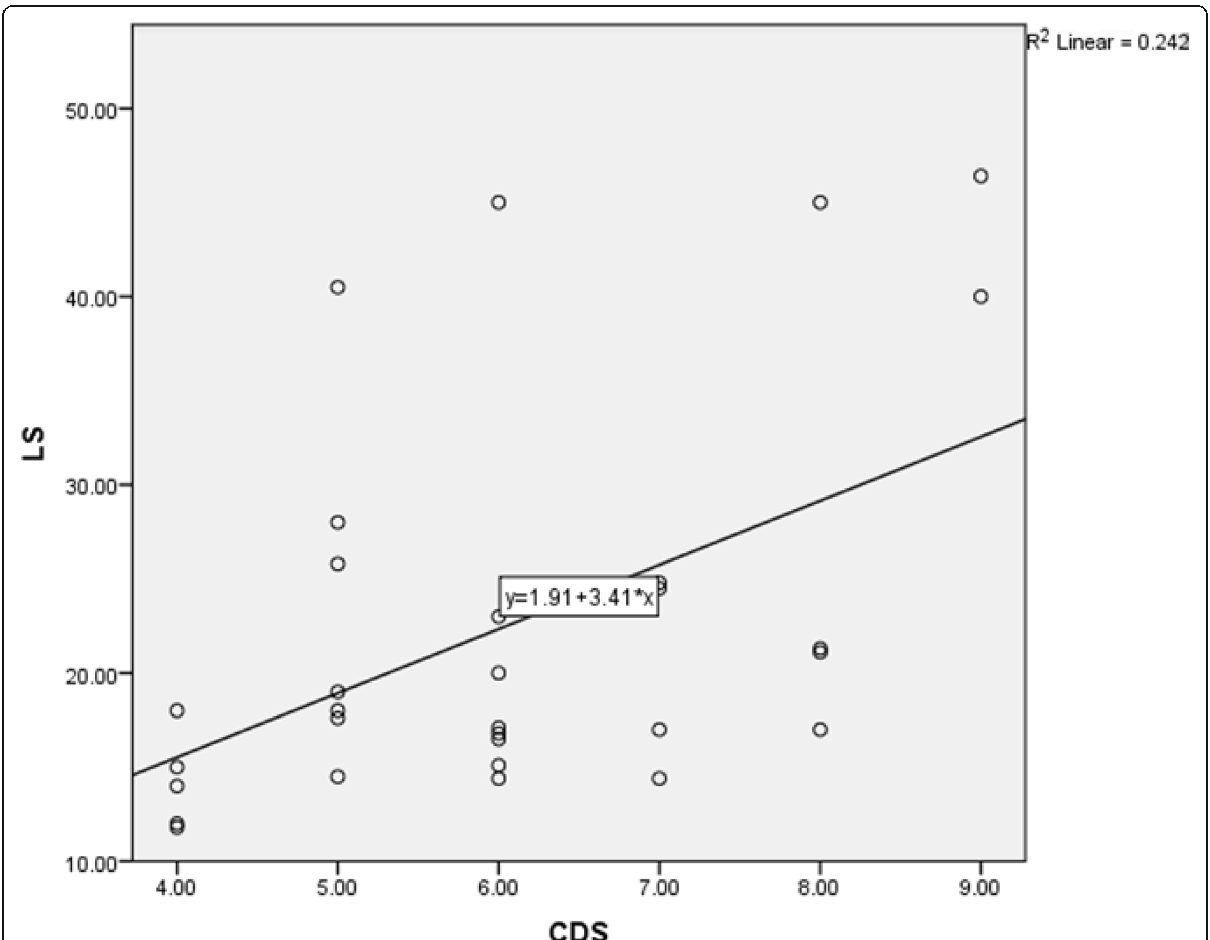
Fig. 3 Scatter plot for the correlation between LS and CDS